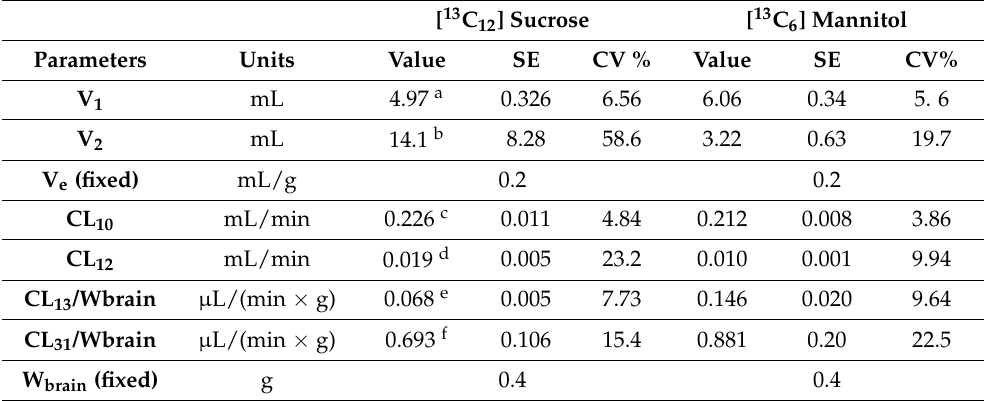
Table 1. Parameters of the 3 compartmental semi-physiologic model for fitting [ 13 C 12 ] sucrose and [ 13 C 6 ] mannitol plasma and brain uptake data simultaneously in adult male mice.